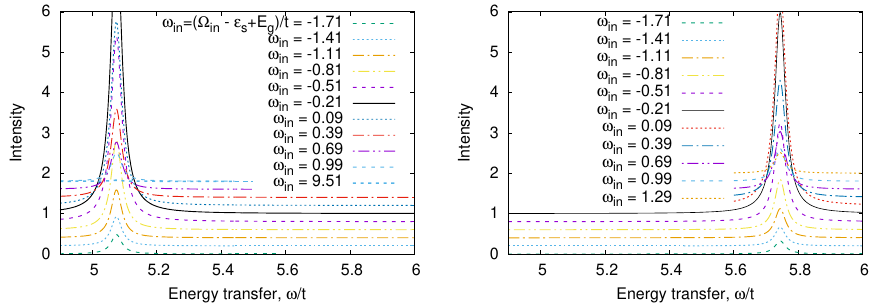
Figure 8. RIXS for | s d (cid:105) (left) and | t d (cid:105) (right) starting states in a “Cu-O-Cu” molecule.